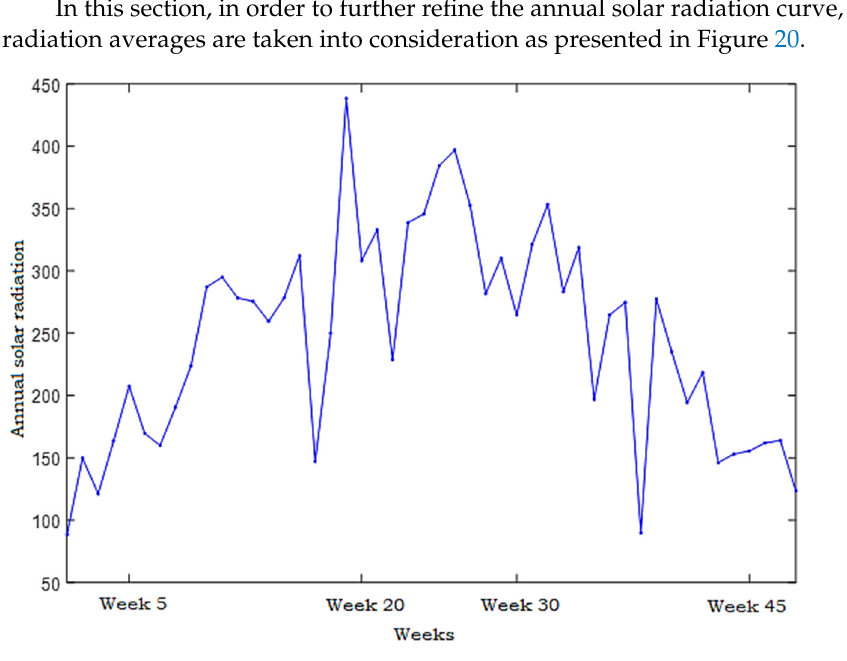
Figure 20. Annual solar radiation evolution considering weekly radiation averages.